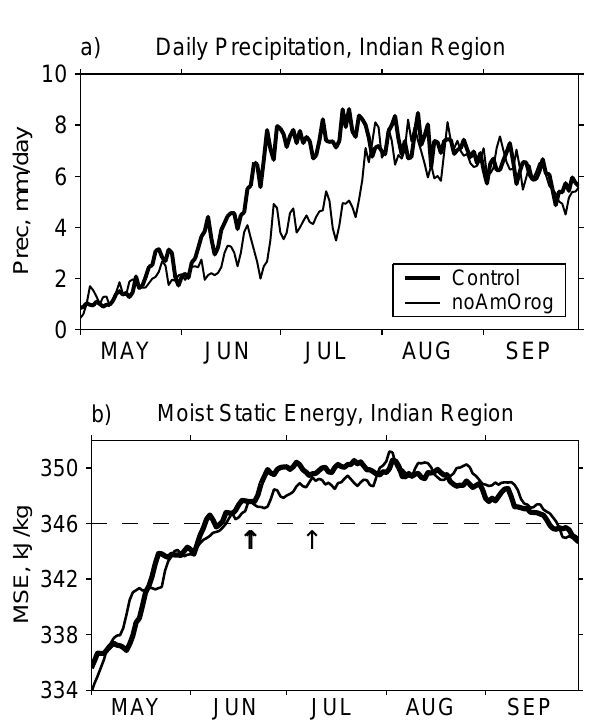
Fig. 16. Evolution of (a) precipitation and (b) moist static energy in the control and noAmOrog